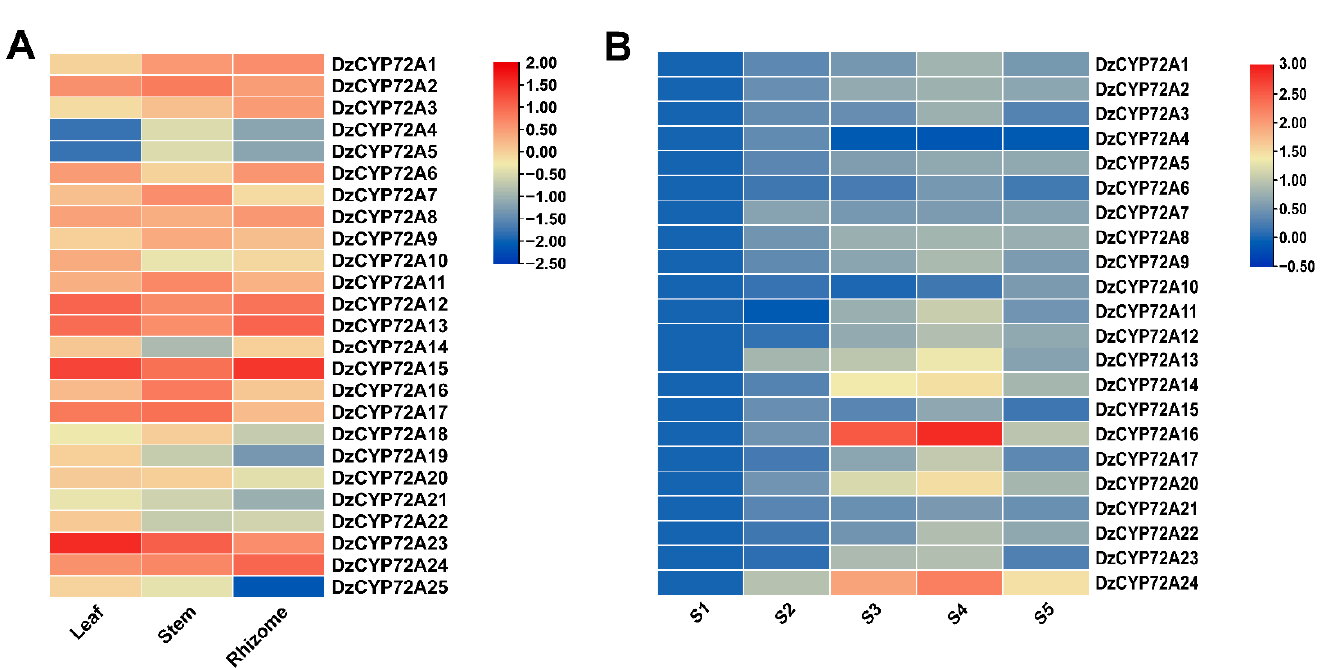
Figure 6. Predicted cis -regulatory elements in promoter regions of DzCYPP72As . ( A ) Tissue-specific expression profile of DzCYP72As . ( B ) Expression patterns of DzCYP72As under jasmonic acid treatment. S1: 0 μ mol/L; S2: 25 μ mol/L; S3: 50 μ mol/L; S4: 100 μ mol/L; S5: 200 μ mol/L. The bar in the upper right corner represents the expression value of log10.